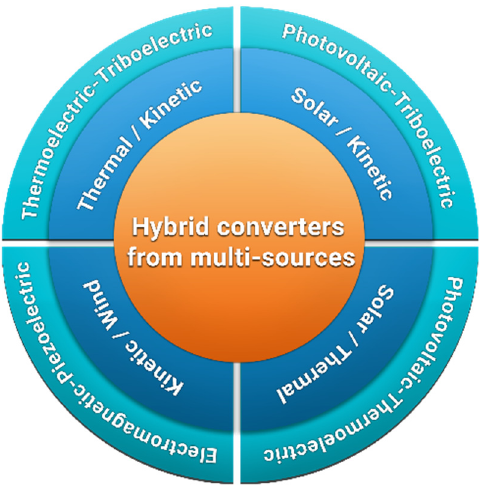
Figure 3. Overview of selected hybrid converters from multi-sources.